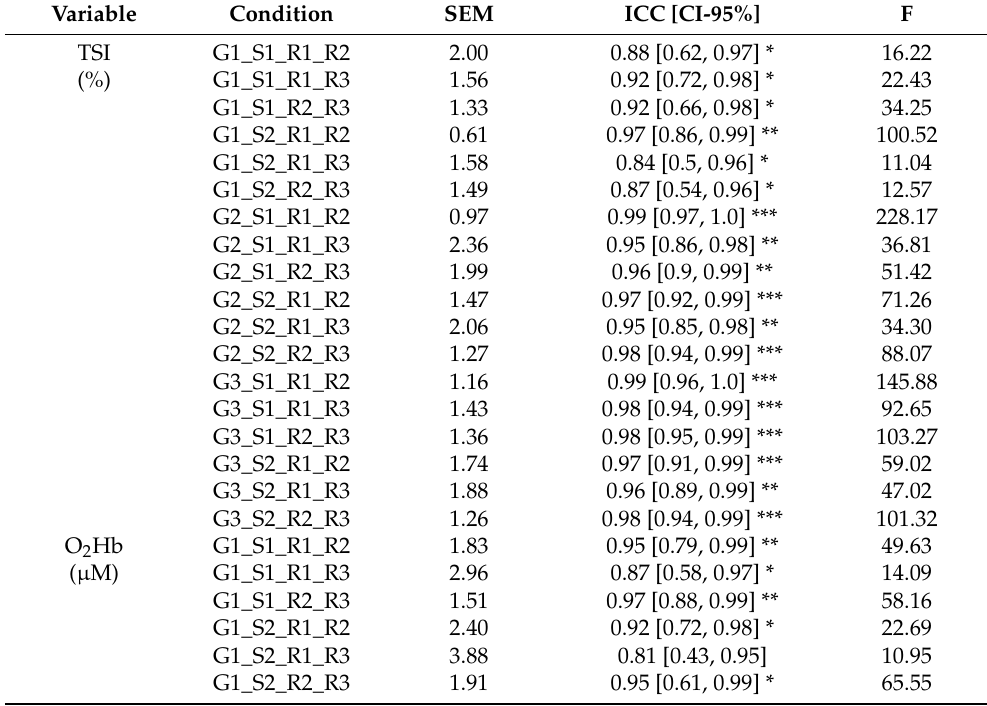
Table 4. Within-participant reliability for